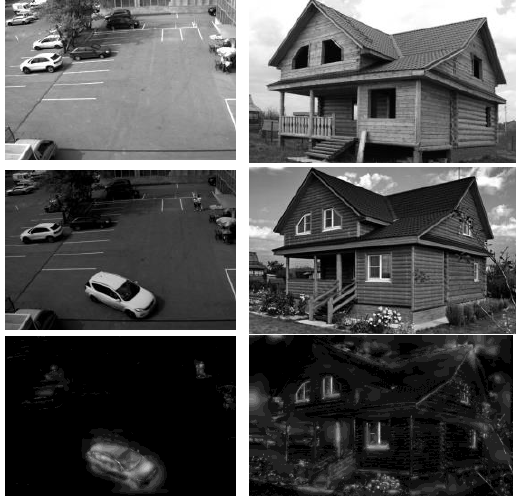
Figure 3. Examples of morphological difference maps based on guided contrasting: first row – reference images; second row – test images; third row – morphological difference maps.